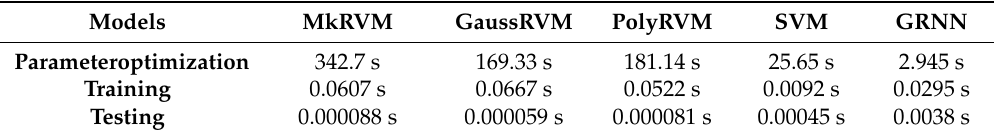
Table 4. Comparison of different models’ computation